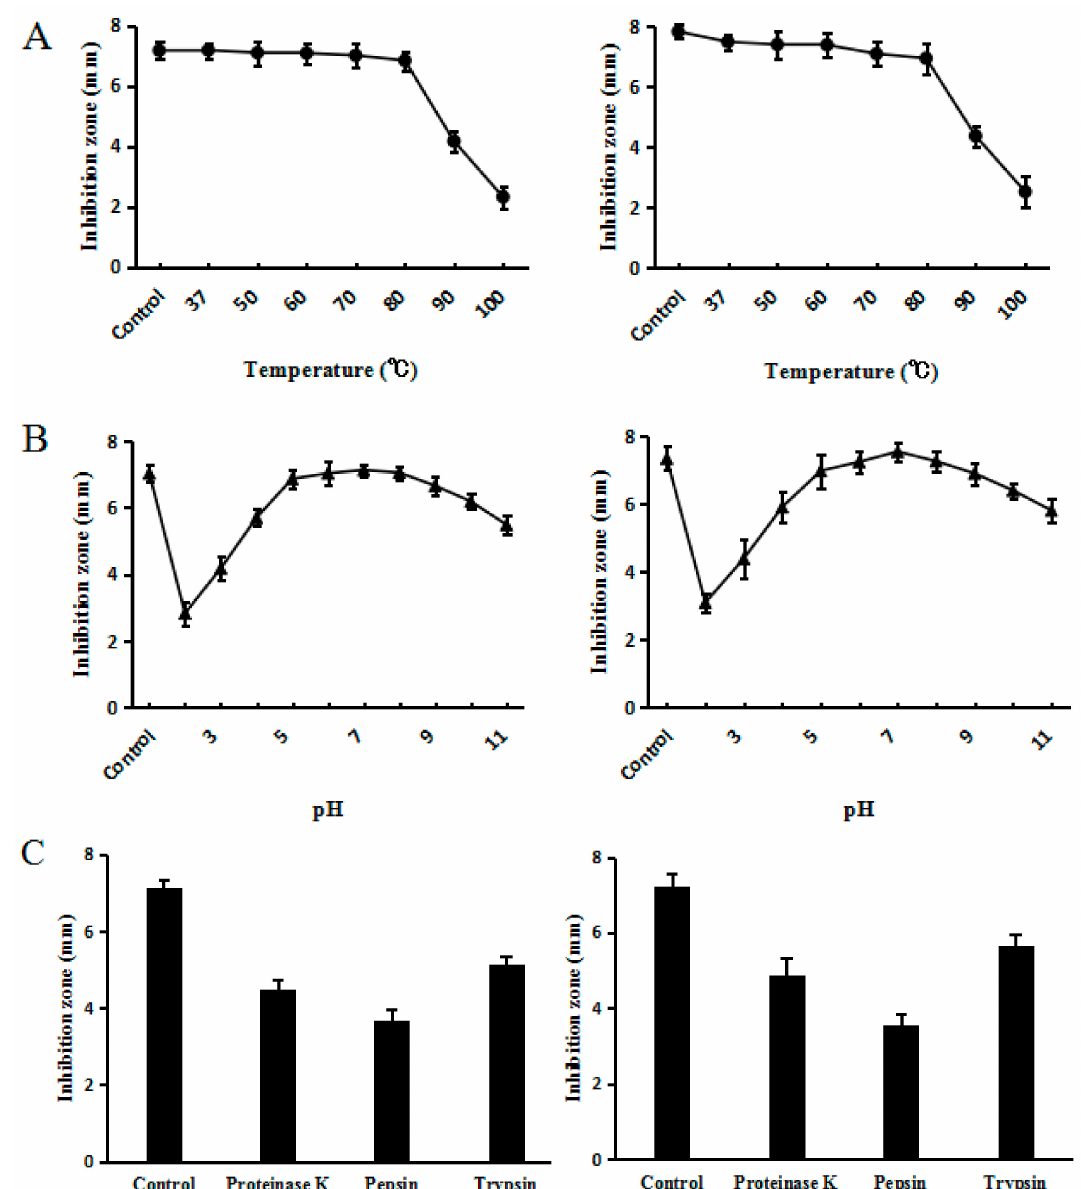
Figure 7. Effects of temperature ( A ), pH ( B ), and proteases ( C ) on recombinant ( left ) and synthesized C–L ( right ). ( A ) The peptide sample kept at 4 ◦ C was used as a control. ( B ) The sample kept in the original culture (pH 6.0) was used as a control. ( C ) The original sample without any enzymatic treatment was used as a control. The graphs were derived from average values for three replicate experiments and error bars show standard deviations. E. coli ATCC25923 was used as the indicator